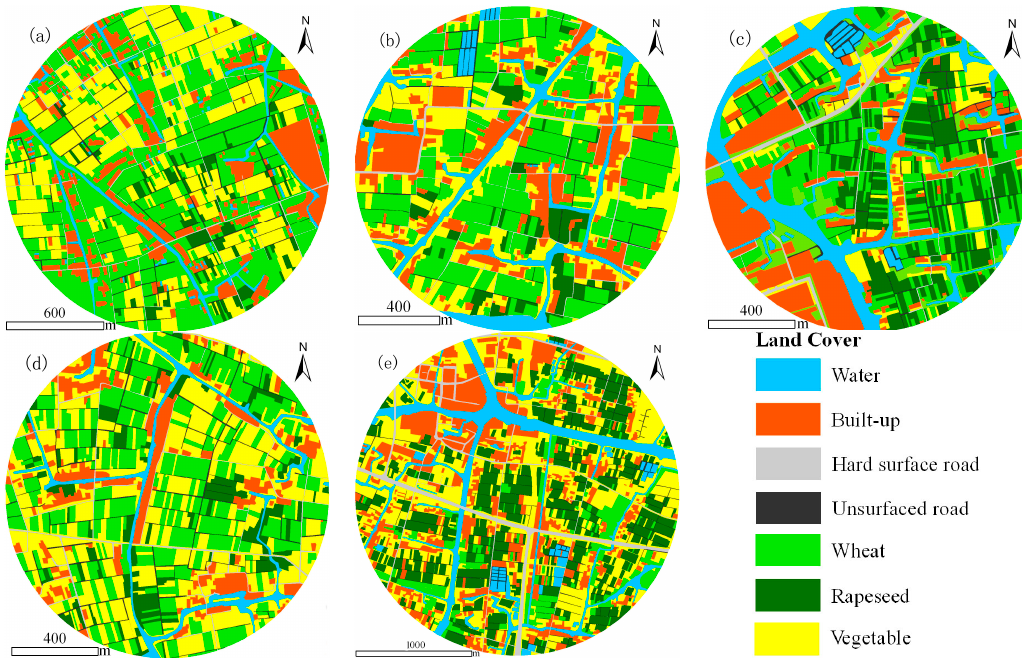
Figure 2. Land cover map of these five study sites. ( a – e ) Indicate study sites TongXiang XinFeng, PingHu, XinHuang, and HaiYan, respectively.